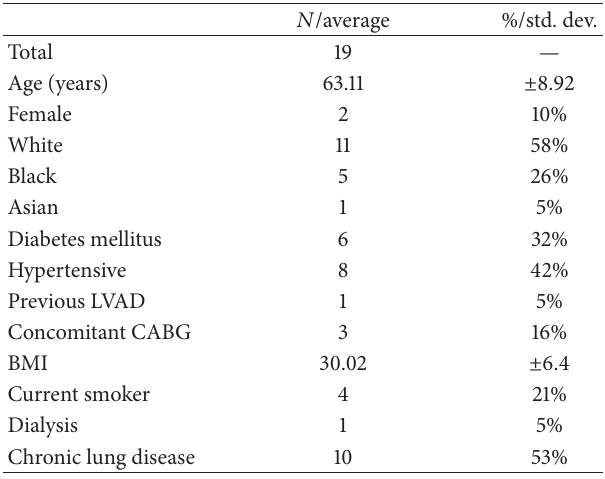
Table 1: Clinical and demographic characteristics of 19 patients who underwent concomitant LVAD insertion and transapical MV repair.